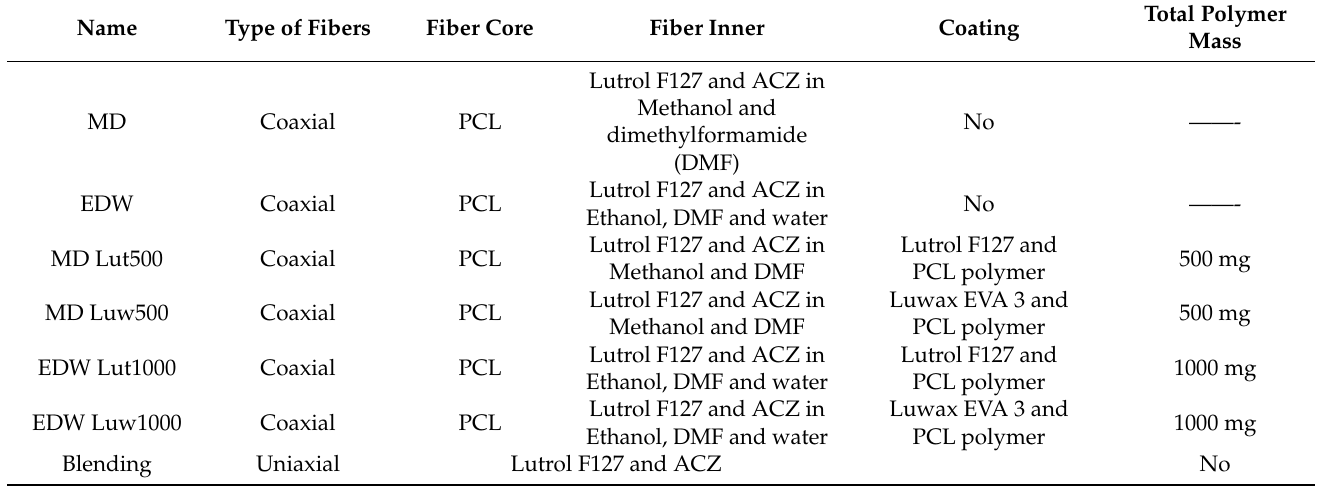
Table 4. Types of implants and their